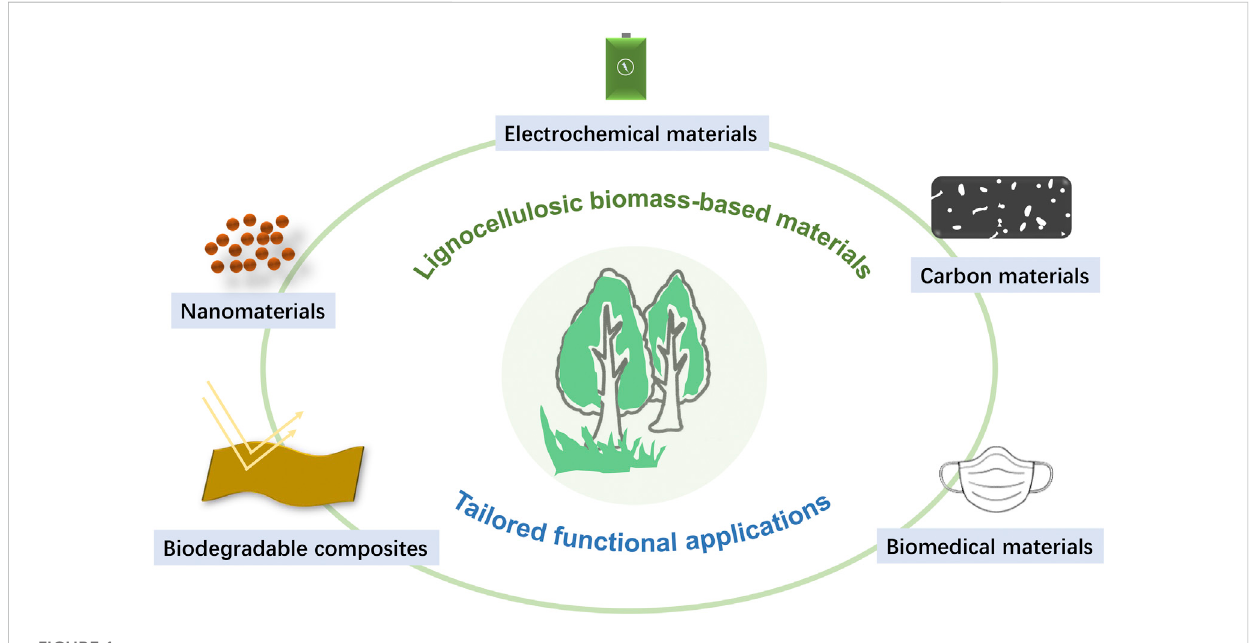
FIGURE 1 Tailored biobased materials from lignocellulosic